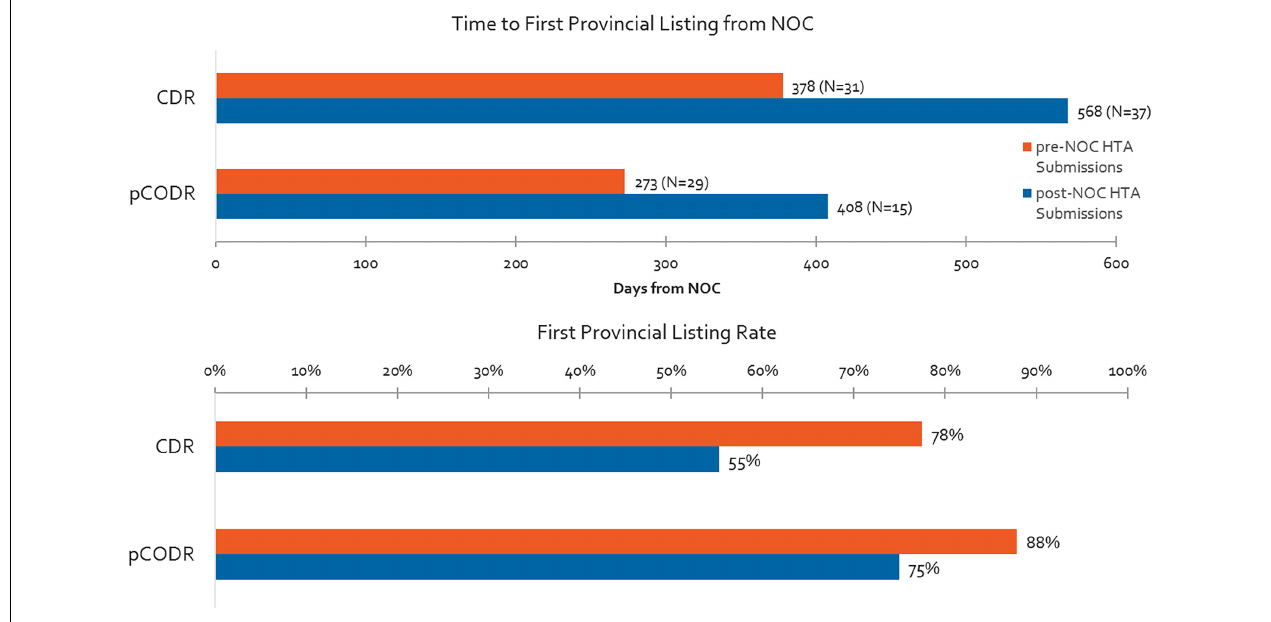
FIGURE 8 | Time to first provincial listing from NOC for products having pre- vs. post-NOC HTA submission, and % listing rates for pre- and post-NOC HTA manufacturer submissions (products with CADTH recommendation to December 2015, time to first provincial listing to December 2016).